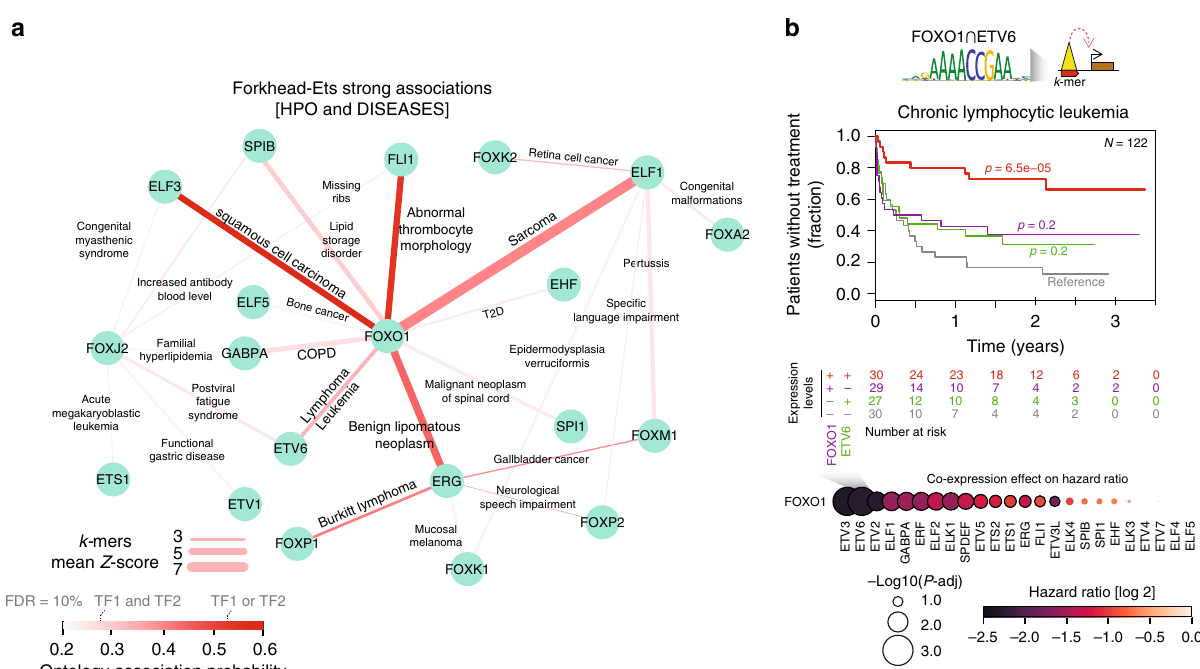
Fig. 6 Functional and disease processes associated to cooperative Forkhead-Ets binding. a Network of strong associations terms between Forkhead and Ets families in HPO and DISEASES ontologies (see Methods section). Nodes indicate TFs and edges indicate ontologies names. Edge width indicates mean of k -mer based Z -scores (features 3 and 4; see Methods section) (COPD = Chronic obstructive pulmonary disease; T2D = Type 2 Diabetes). FDR thresholds in color scale indicate TF1 and TF2 and TF1 or TF2 con fi dence for association probabilities obtained using the HPO ontologies database (extended thresholds in Supplementary Data 7). b Cartoon describing association between Forkhead + Ets k -mer GAAAACCGAANM and lymphoma associated genes through intersected peaks (top). Kaplan-Meier plot of time-to-treatment in Chronic lymphocytic leukemia patients when using FOXO1 and ETV6 expression medians (middle) (high and low expression are de fi ned as above and below median values, and labeled as + and − , respectively). p -values are derived from two-sided log-rank comparison with respect to − / − expression levels for both FOXO1 and ETV6 (data from Dietrich et al. 36 ). Dot plot showing co-expression effect on time-to-treatment for all pairs between FOXO1 and members of the Ets family (bottom). Values are sorted by decreasing signi fi cance (from left to